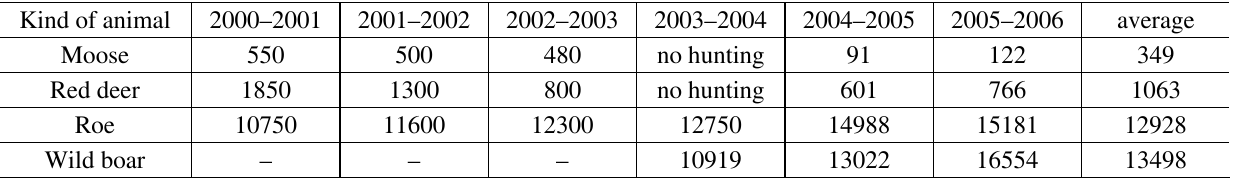
Table 1. Number of game hunted in Lithuania in 2000–2006, in units [13–16] Kind of animal Moose Red